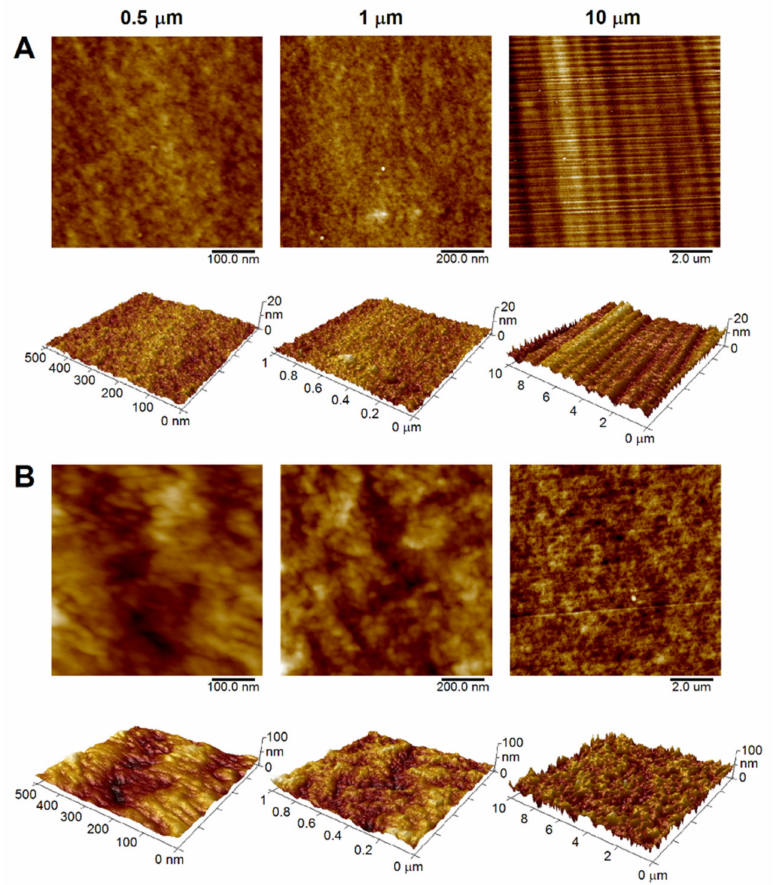
Figure 3. Two-dimensional and three-dimensional AFM scans of ultramicrotome-cut PET ( A ) and PEEK ( B ) surface, scan sizes of 0.5, 1 and 10 µ